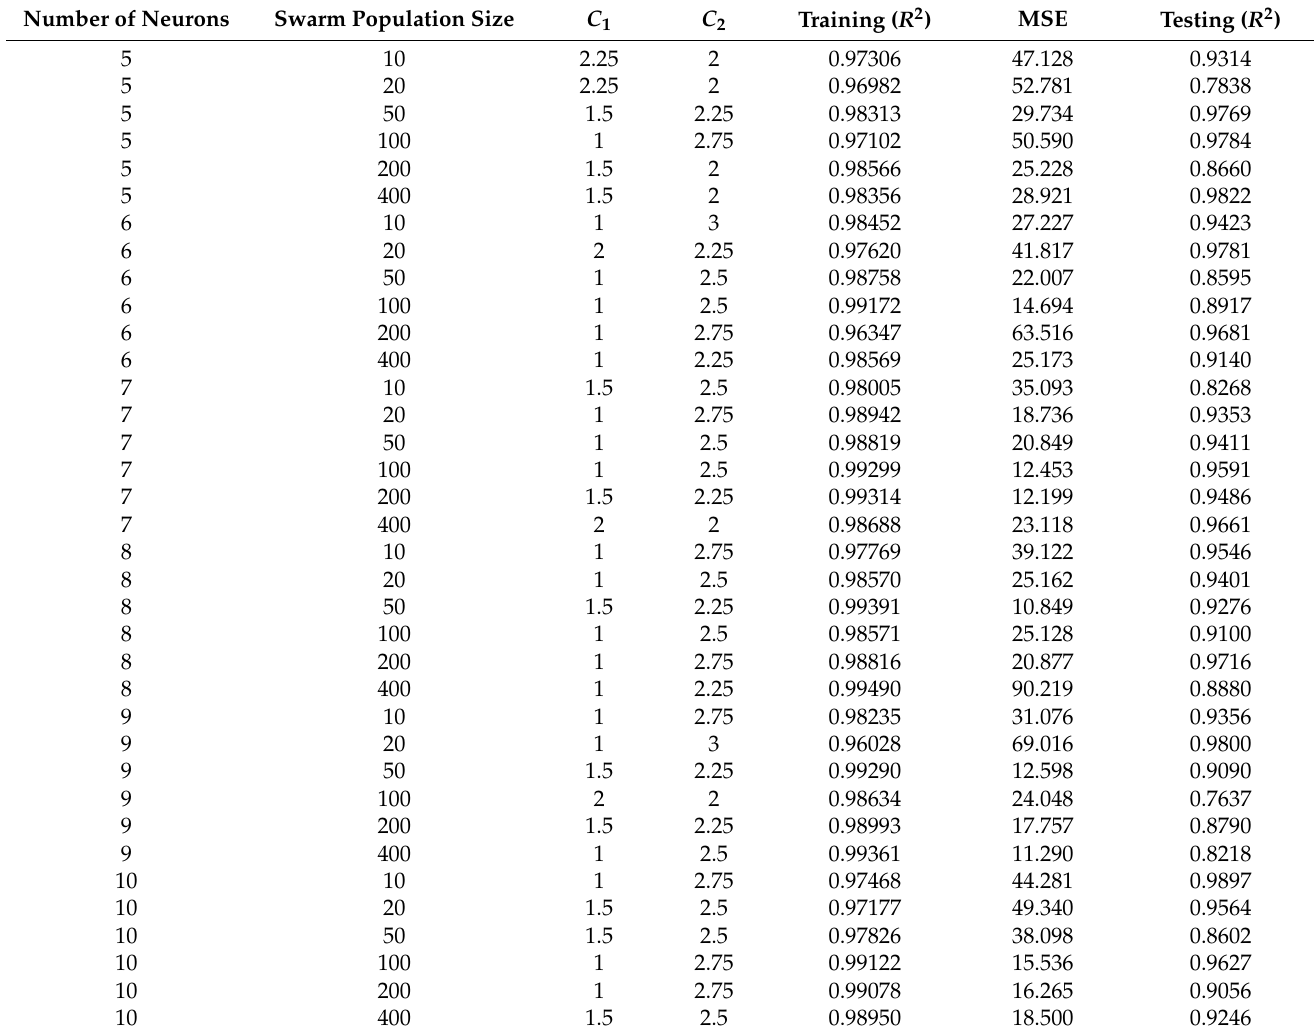
Table 6. The Parametric analysis of ANN-PSO Hybrid Model for the Traffic